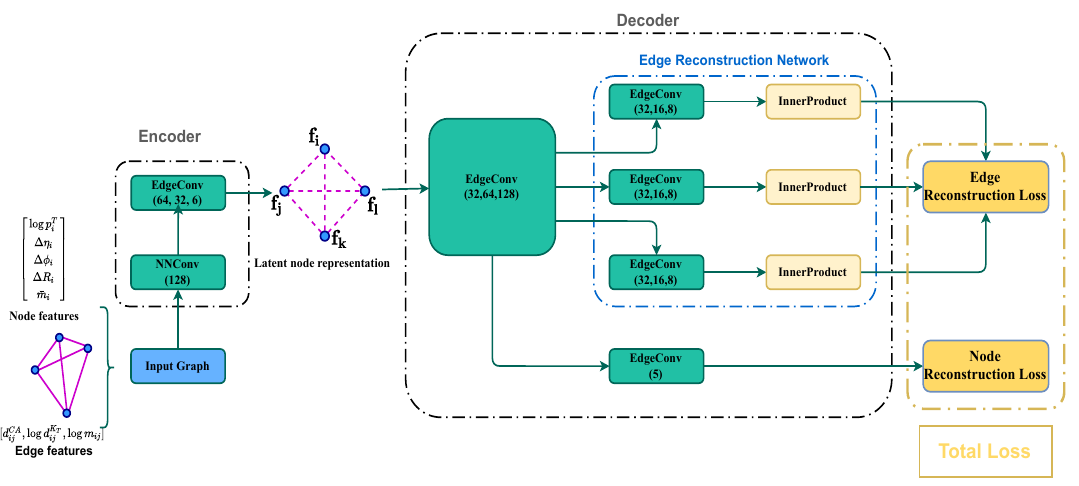
Figure 3 . A schematic representation of a graph-autoencoder network. The network contains the (a) Encoder and the (b) Decoder. We employ an edge reconstruction network in the decoder to reconstruct the multidimensional edge